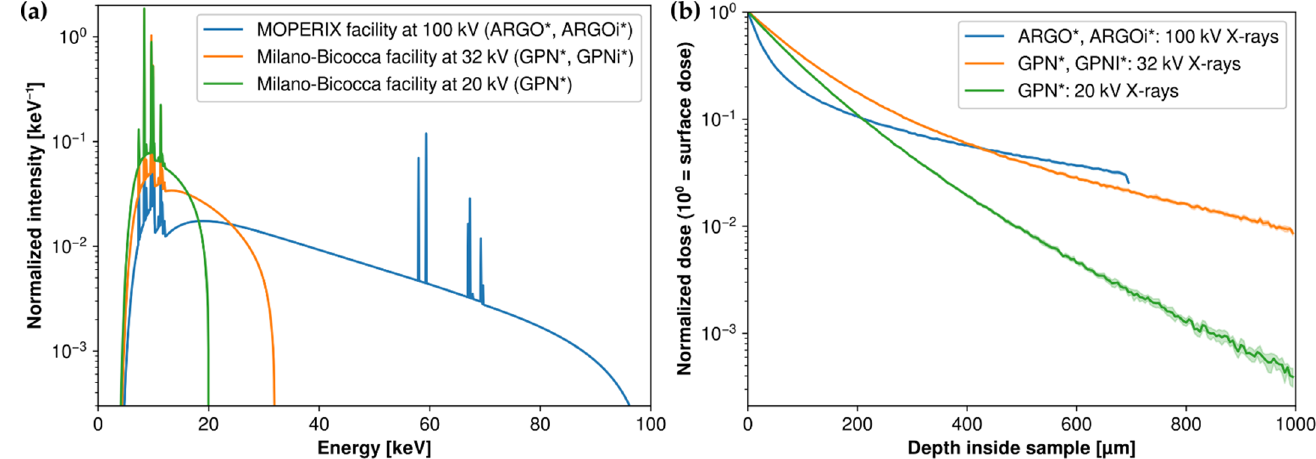
Figure 6. ( a ) X-ray energy spectra simulated by SpekPy for each irradiation facility, normalized by integral. ( b ) Geant4-simulated dose inside each sample, normalized by the surface dose; filled areas show uncertainties at 95% confidence.